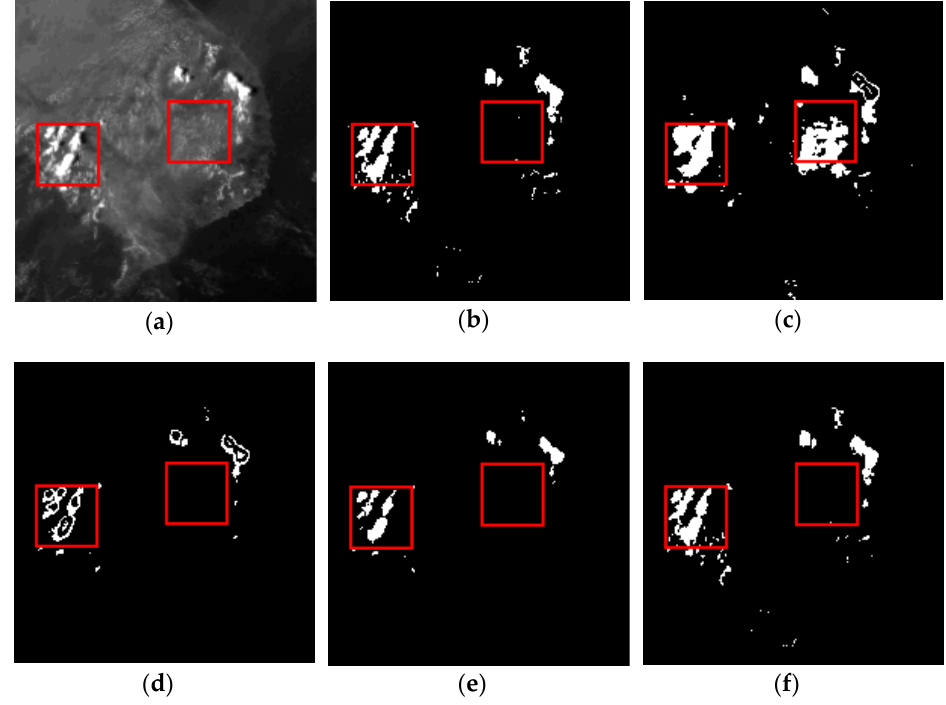
Figure 8. The enlarged subset of results. ( a ) Visible image; ( b ) Ground truth; ( c ) NSMC result; ( d ) NSMC-RF result; ( e ) Ensemble threshold-RF result; ( f ) Proposed RF result.